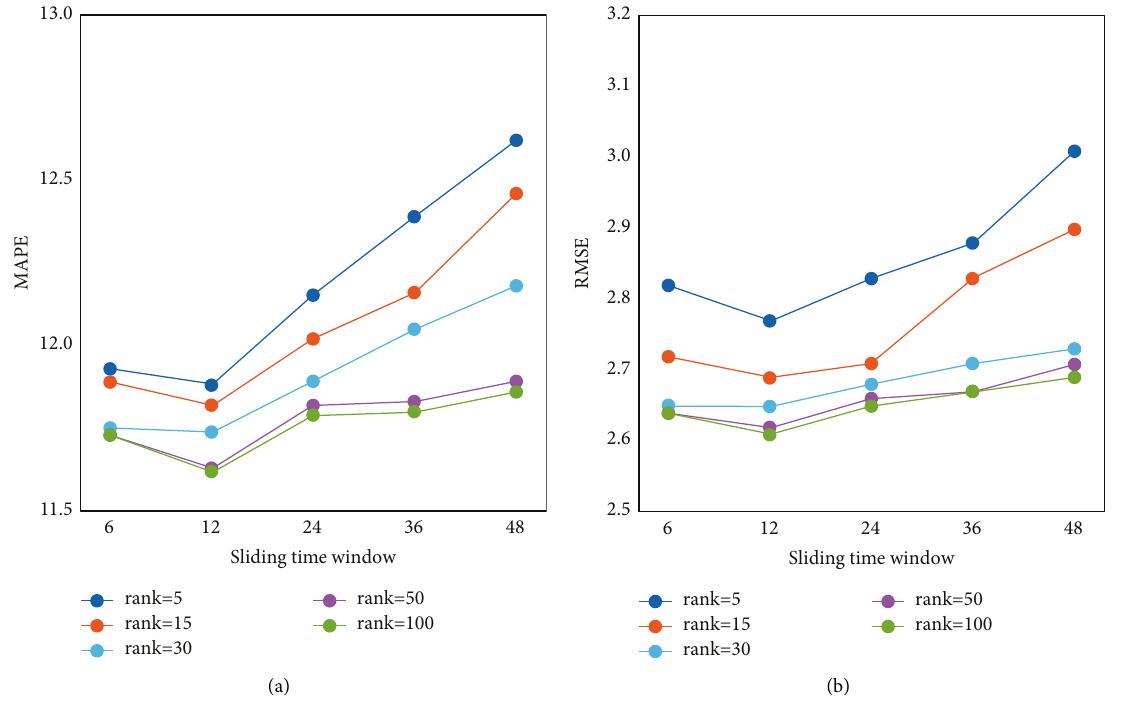
Figure 11: Comparison of the DTBPD model with different parameters. (a) MAPE; (b)